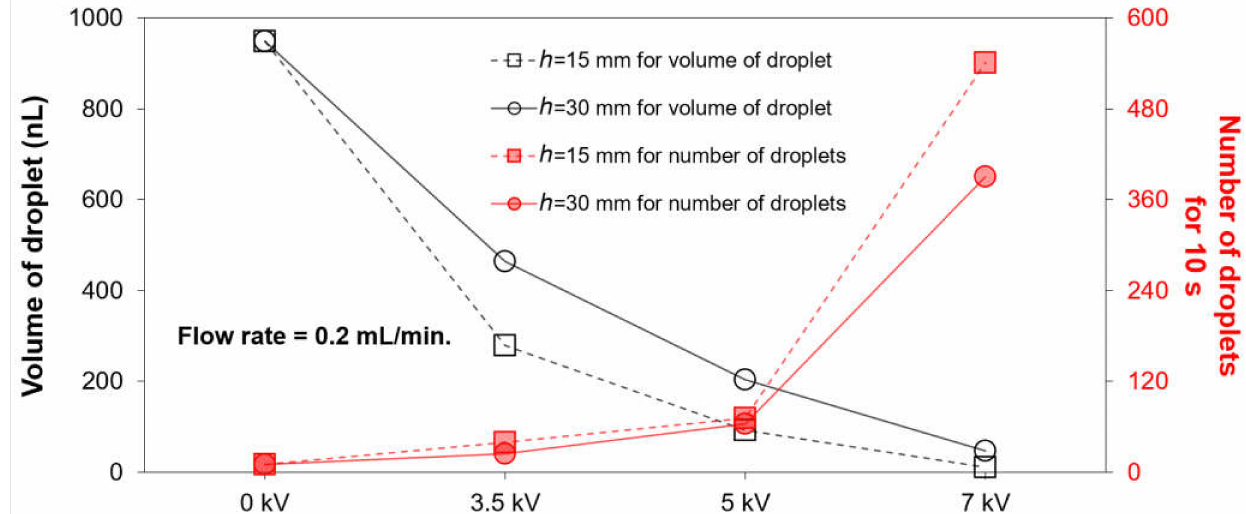
Figure 5. Impacts of height between the needle and circular-shaped Cu electrode on the volume and number of the generated gallium-based liquid metal droplet(s) ejected from the needle at the flow rate of 0.2 mL/min, by applying various voltages (0, 3.5, 5, and 7